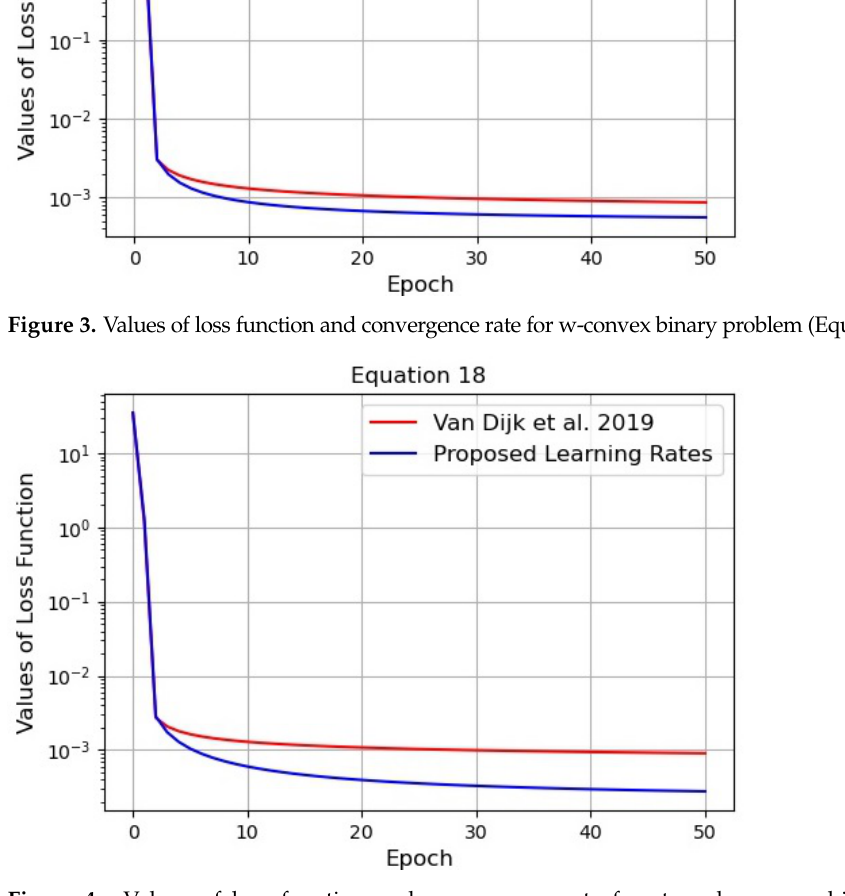
Figure 4. Values of loss function and convergence rate for strongly convex binary problem (Equation (18))